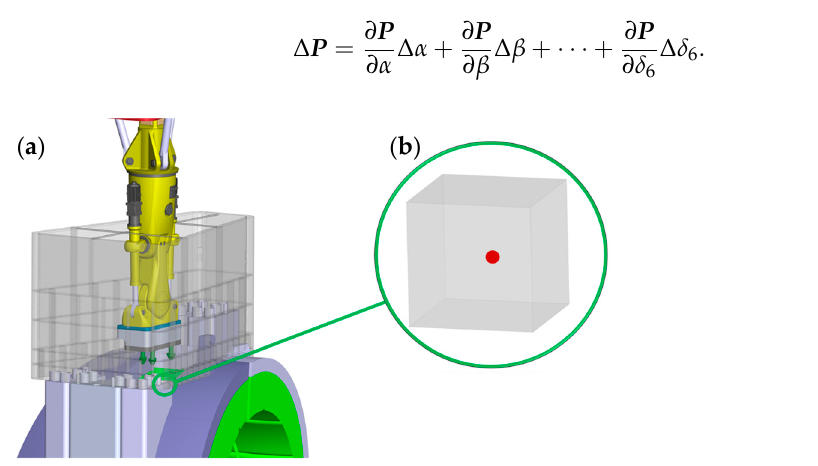
Figure 11. HKM workspace variable density meshing ( a ); a set of parameters is used to compensate for one grid region ( b ).